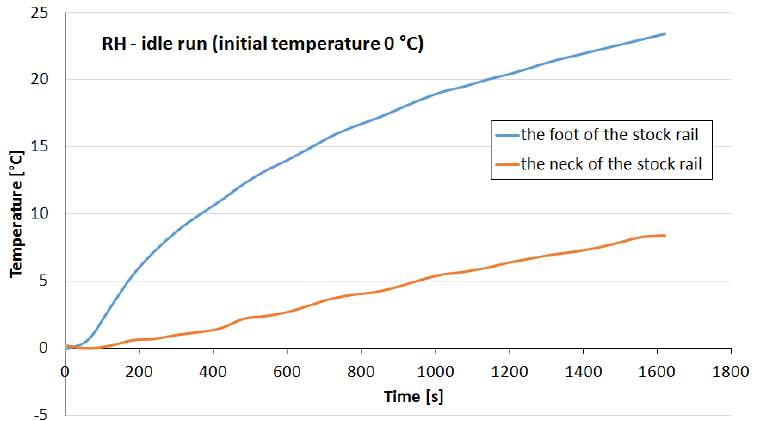
Figure 13. Foot and rail neck temperature vs. heating time in empty run of RH device for initial temperature 0 °C.